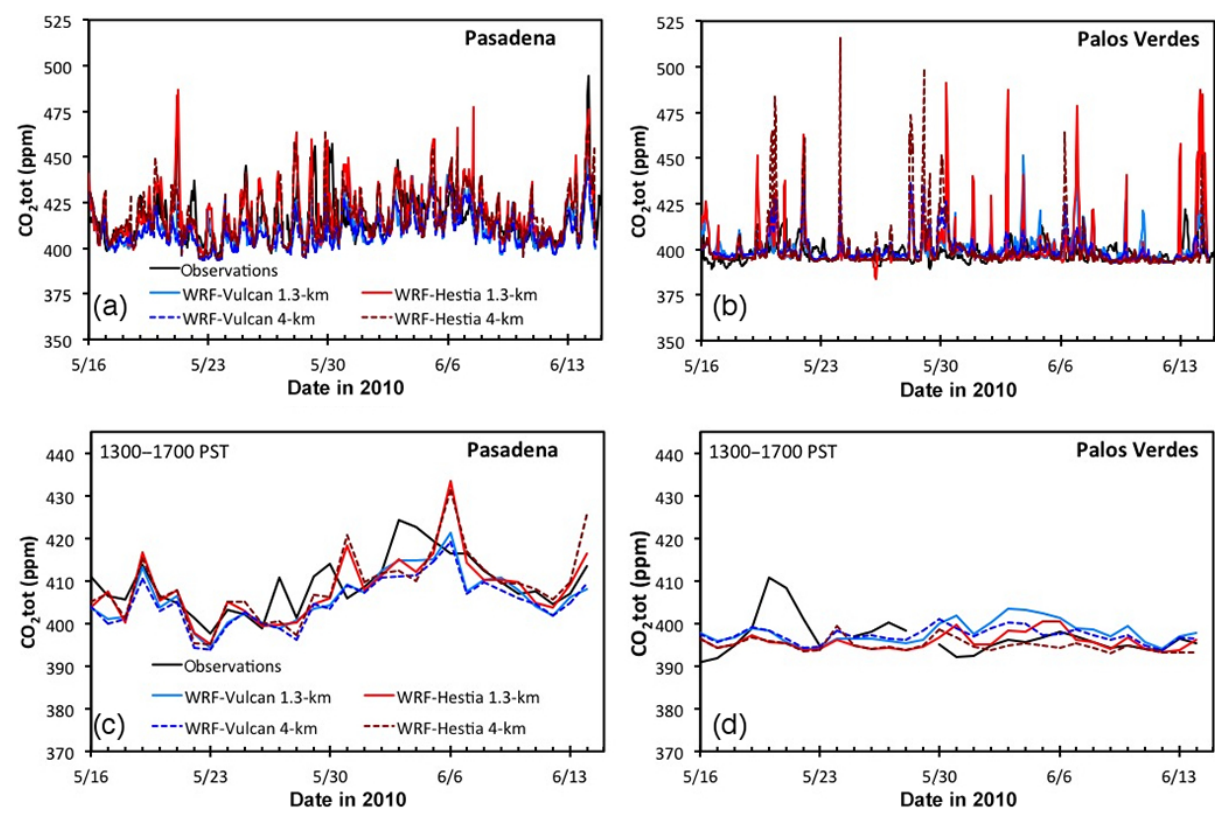
Figure 8. Comparison of the observed and modelled CO 2 concentrations at the (a) Pasadena and (b, d) Palos Verdes sites: (a, b) hourly time series, (c, d) daily afternoon averages for